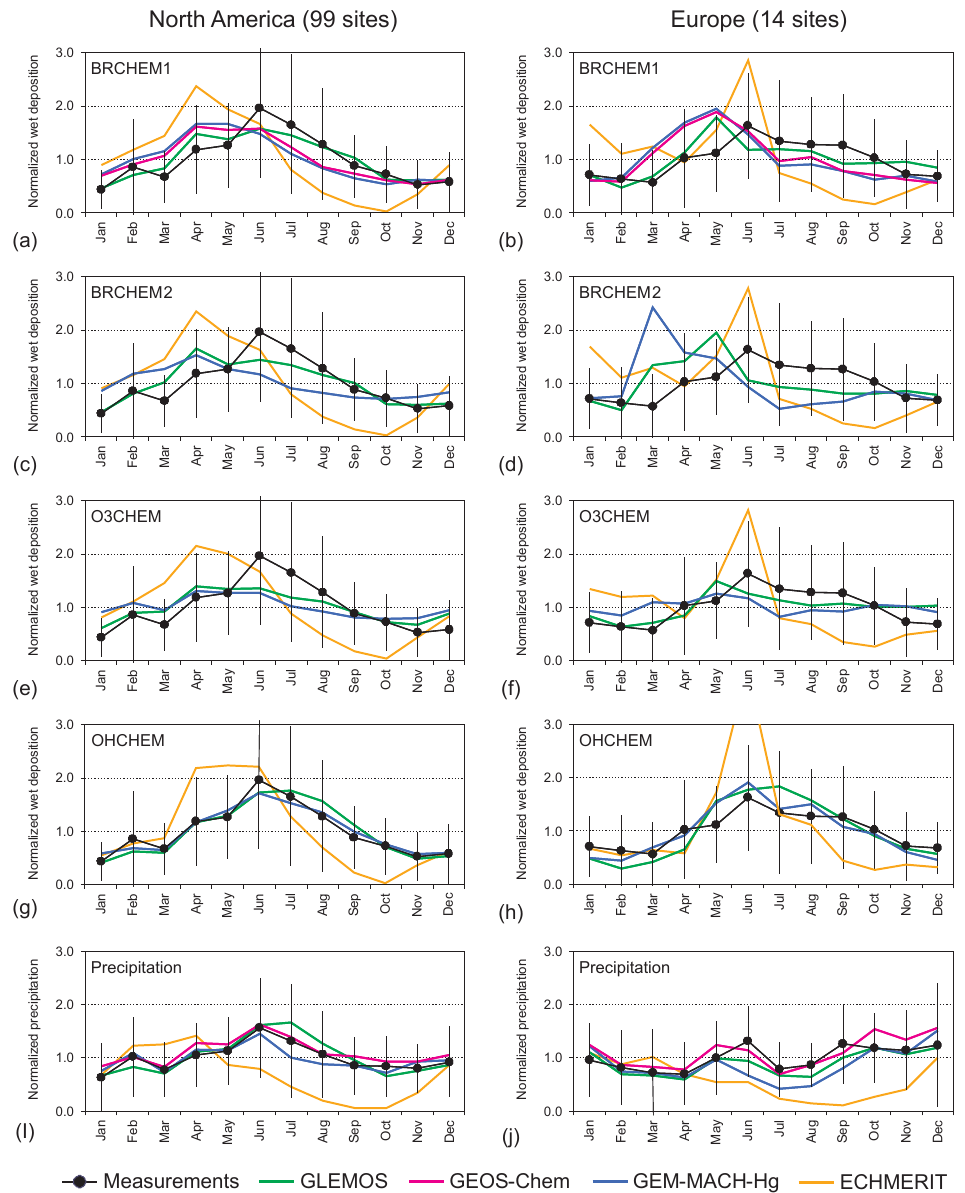
Figure 12. Normalized seasonal variation of monthly mean wet deposition flux in North America (left column) and Europe (right column). Black line with dots shows observations averaged over all sites in the regions (whiskers are standard deviation). Colored lines present model simulations averaged over the same sites for different model experiments: (a, b) BrCHEM1, (c, d) BrCHEM2, (e, f) O3CHEM, and (g, h) OHCHEM. Seasonal variations of precipitation amount in North America and Europe are also shown in panels (i) and (j) ,